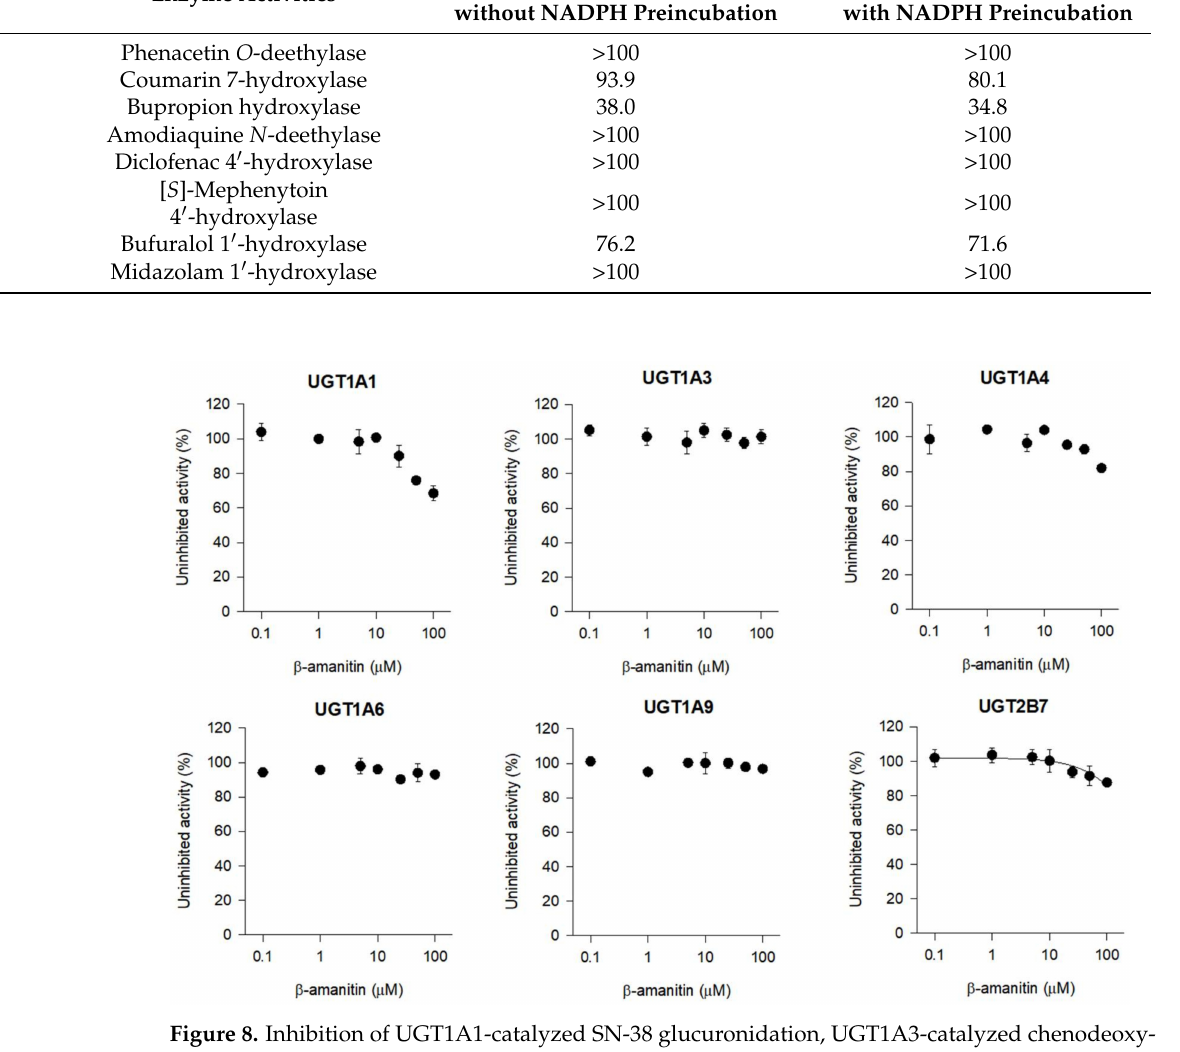
Figure 8. Inhibition of UGT1A1-catalyzed SN-38 glucuronidation, UGT1A3-catalyzed chenodeoxy- cholic acid 24-acyl-glucuronidation, UGT1A4-catalyzed trifluoperazine N -glucuronidation, UGT1A6- catalyzed N -acetylserotonin glucuronidation, UGT1A9-catalyzed mycophenolic acid glucuronidation, and UGT2B7-catalyzed naloxone 3- β -D-glucuronidation by β -amanitin in human liver microsomes using cocktail substrates and LC-MS/MS. Each data point represents mean ± SD ( n =